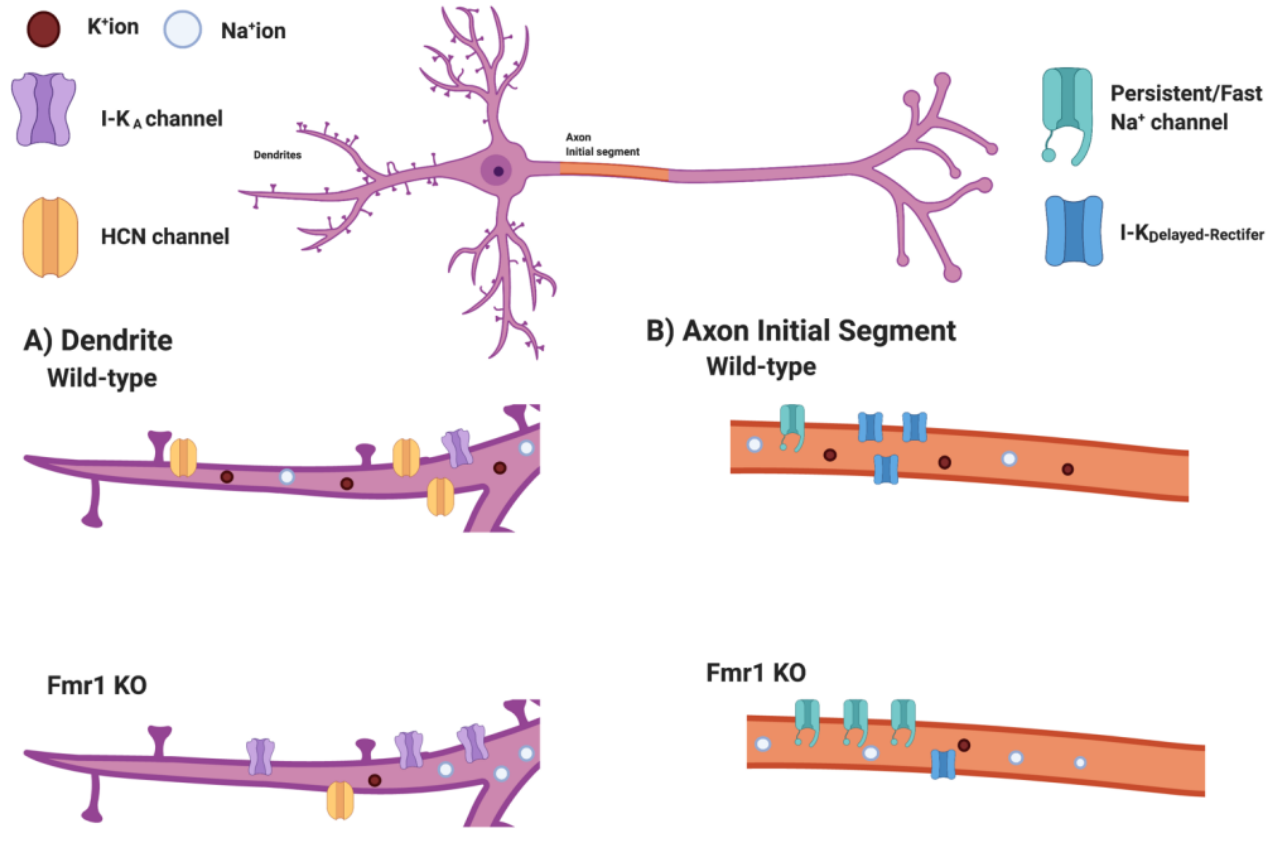
Figure 2. Ion channel dysregulations that contribute to cortical hyperexcitability in Fmr1 KO neurons. ( A ) Fmr1 KO dendrites present with altered composition of ion channels when measured with electrophysiological and immunofluorescence measures. Increased I-K A currents (potentially mediated by Kv4.2 channels) can support faster firing of dendritic action potentials. Reduced HCN currents (likely through HCN1 channels) reduce dendritic hyperpolarization, thus disinhibiting dendritic action potential firing. ( B ) Fmr1 KO axons display increased currents through persistent and fast Na + channels, both of which are associated with neuronal hyperexcitability. The increase in Na + currents is combined with reduced delayed rectifier K + currents, further enhancing a hyperexcitable state of the Fmr1 KO axon.